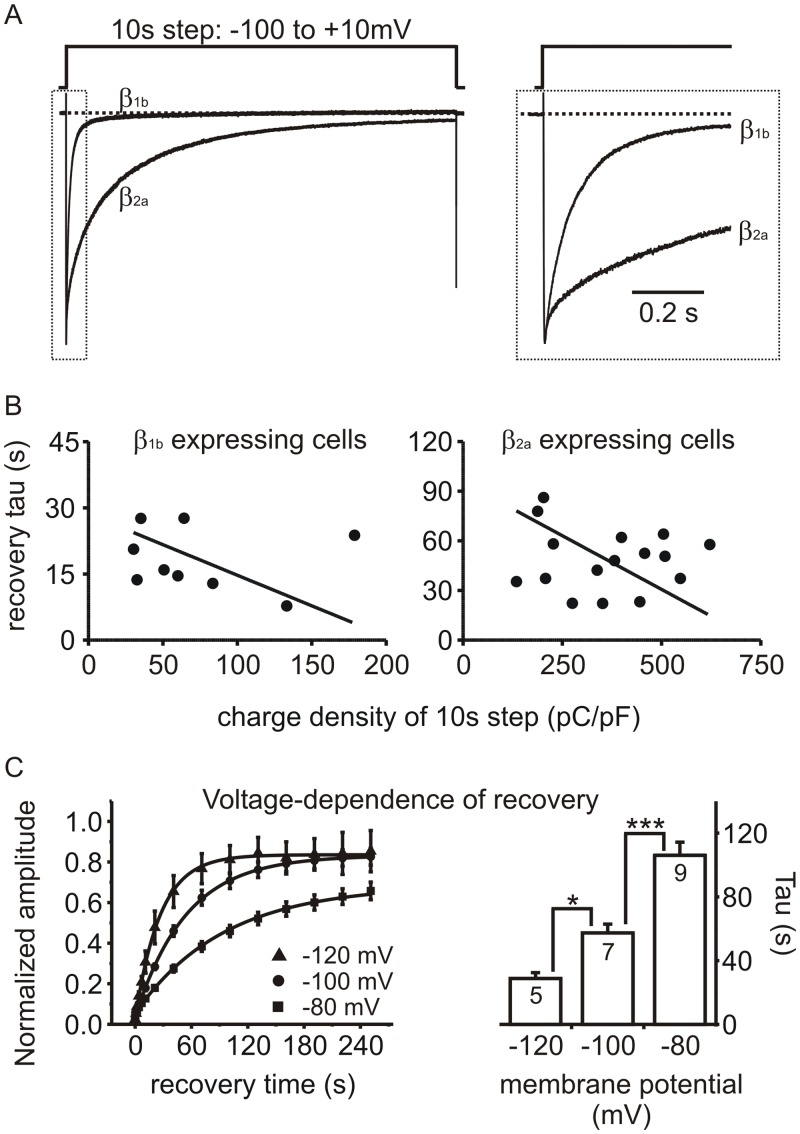
Recovery of CaV2 channels from “slow” inactivation: dependence on voltage and CaV β subunit, but not charge density.
(A) Representative I
Ba from HEK293 cells transfected with CaV2.2, α2δ, and either β1b or β2a subunits. In both cases inactivation was almost complete by the end of the 10s step, but the β2a subunit dramatically reduced “fast” inactivation. The right panel shows the initial ~600ms of the traces on an expanded time base. (B) Recovery rate was not correlated with barium entry. Inactivation was produced by a 10s prepulse and recovery tracked as in Fig 1F. The recovery time constant (tau) is plotted against charge density (i.e. the integral of I
Ba during the 10s prepulse normalized to cell capacitance. The solid line shows a linear fit using Deming regression. The slope of this line was not significantly different from zero (p = 0.75 for β1b expressing cells and p = 0.76 for β2a expressing cells). (C) Recovery from inactivation was voltage-dependent. Inactivation of β2a containing channels was produced by a 10s prepulse and recovery tracked at different holding potentials (-80 mV, -100 mV, or -120 mV). Solid lines show exponential fits to the mean data (-120mV holding A = 0.79, t = 24.8 s; -100mV holding A = 0.8, t = 54.7 s; -80 mV holding A = 0.62, t = 103.2 s). The bar graph plots the mean time constant calculated from fits to the individual cells (* p < 0.05, *** p < 0.001 using ANOVA and Tukey’s post-test for pairwise comparisons).